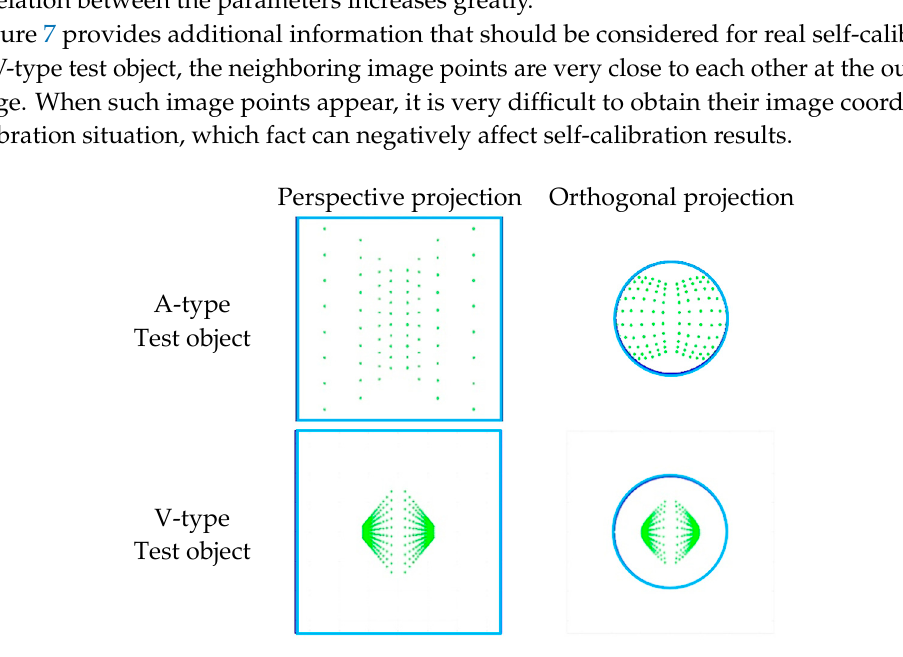
Figure 7. Distribution of image points according to different test object type (A and V).